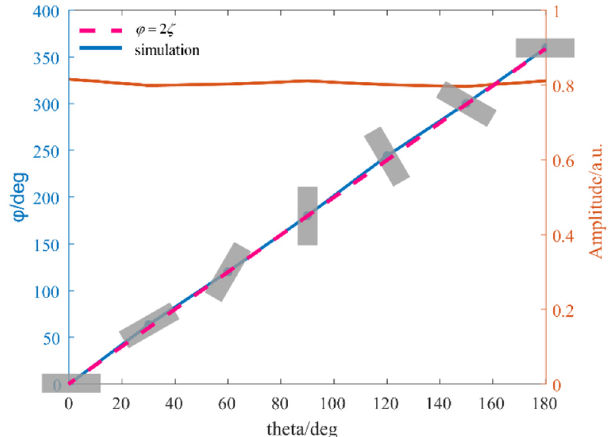
Fig. 7. Simulation effect of geometric phase control of the unit